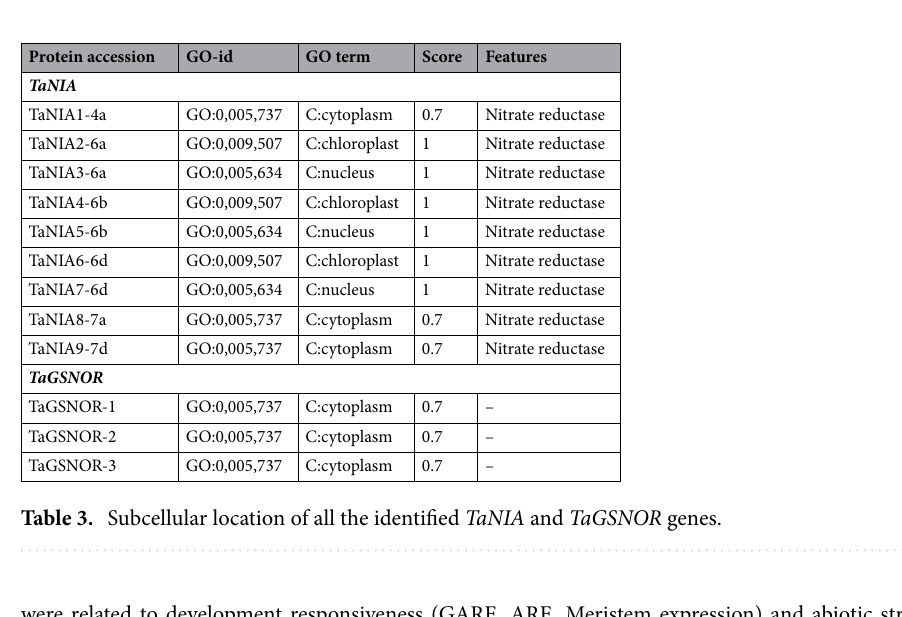
Table 2. Details of TaNIA and TaGSNOR genes proteins including average residue weight g/mol, charge, isoelectric point, molecular weight, theoretical PI, instability index, aliphatic index, grand average of hydropathicity (GRAVY) and stability.